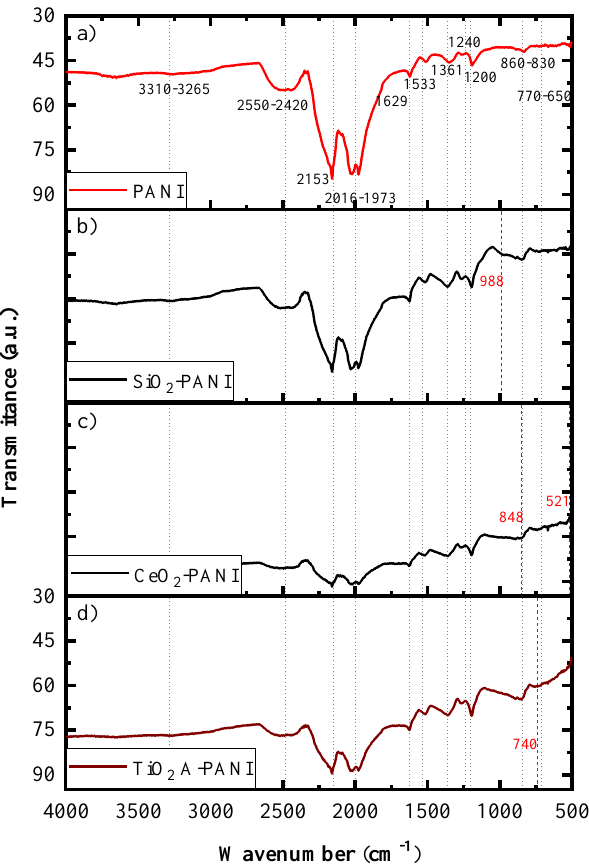
Figure 5. FTIR spectra for ( a ) PANI and nanocomposites of ( b ) SiO 2 -PANI, ( c ) CeO 2 -PANI, and ( d ) TiO 2 A-PANI.